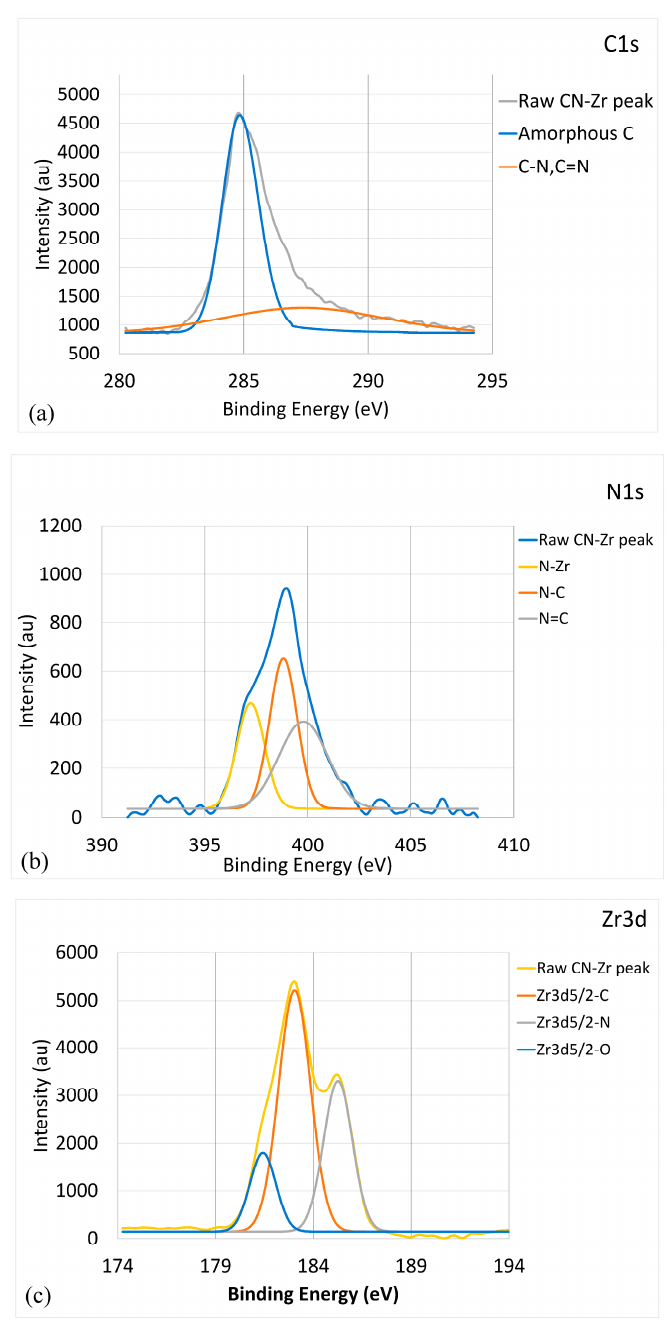
Figure 2. Bonding energy of CNx-Zr coating characterized by XPS: ( a ) C1s XPS raw and deconvoluted spectra; ( b ) N1s XPS raw and deconvoluted spectra; and ( c ) Zr3d raw and deconvoluted spectra.